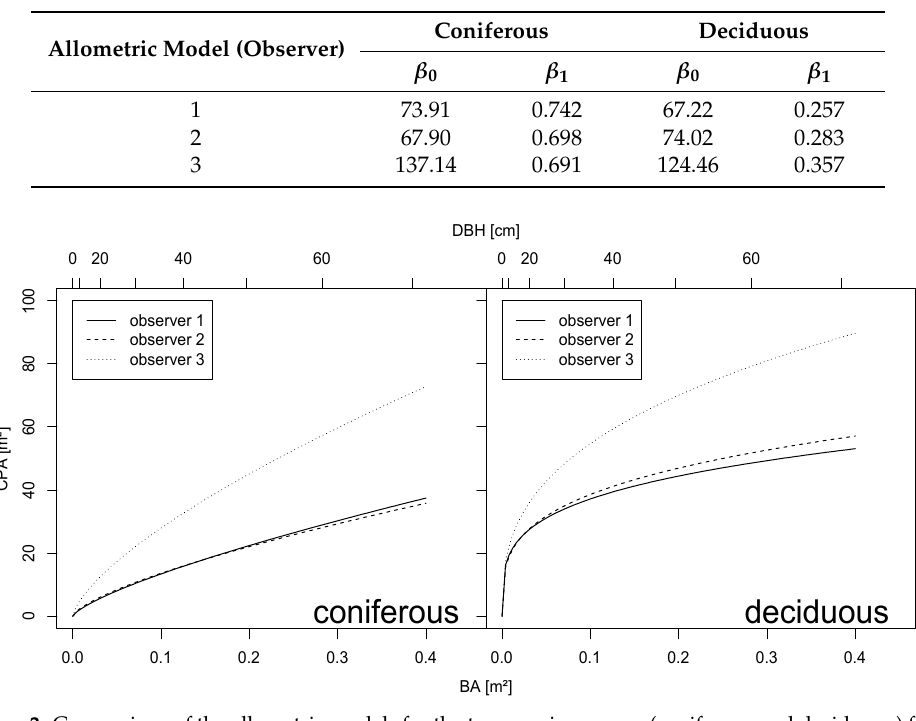
Figure 3. Comparison of the allometric models for the two species groups (coniferous and deciduous) fitted to the data obtained independently by the three different observers. BA = basal area, DBH = diameter at breast height, and CPA = crown projection area.